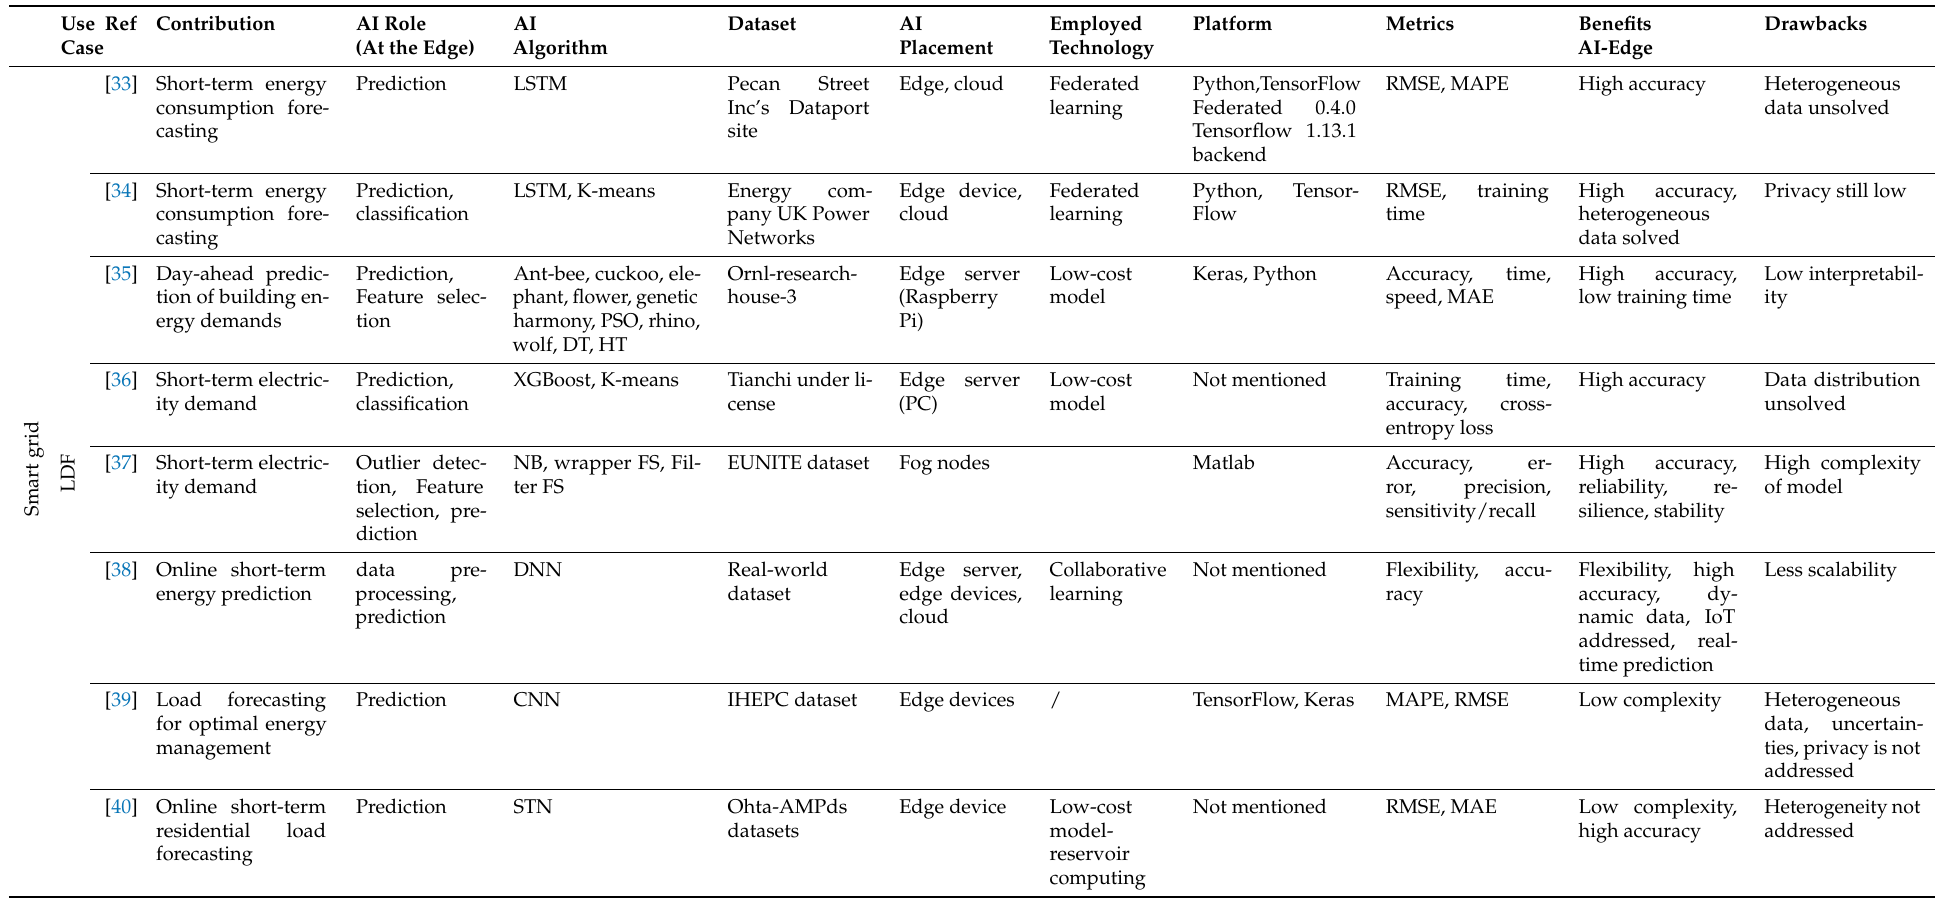
Table 4. Qualitative comparison of smart grid related